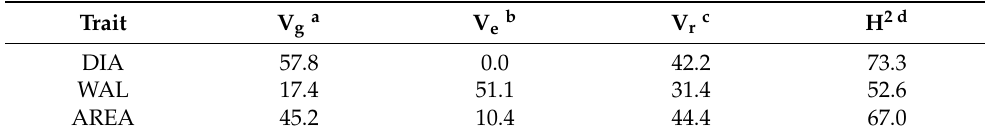
Figure 1. Frequency distribution of measured peduncle morphology traits 2017 and 2018 with highlighted Barke mean (dot dashed line). Traits: Peduncle diameter (DIA [ µ m]), total thickness of peduncle tissues (WAL [ µ m]), area of the peduncle cross-section (AREA [mm 2 ]); n = 1232 (2017), n = 1343 (2018). Table 2. Broad-sense heritability across all genotypes of the traits DIA, WAL, and AREA with respective variance